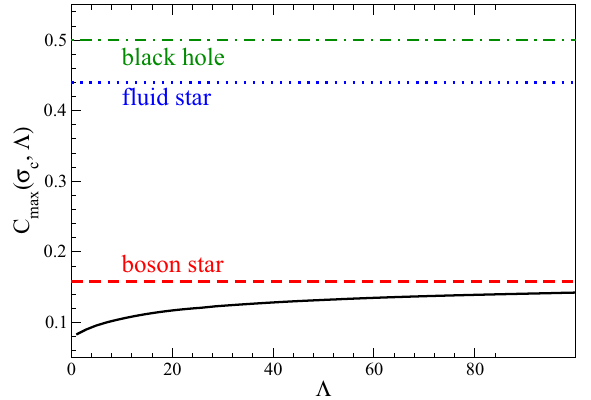
Fig. 4 The compactness of a stable boson star (black solid line) as a function of the adimensional self- (cid:6) (cid:7) interaction parameter Λ ≡ λ/ 4 π Gm 2 . The compactness is shown for the most massive stable star (the most compact BS is unstable). This compactness asymptotes for Λ → ∞ to the value indicated by the red, dashed line. Also shown for comparison is the compactness of a Schwarzschild BH (green dot-dashed line), and the maximum compactness of a non-spinning neutron star (blue dotted line). Reprinted with permission from Amaro-Seoane et al. (2010); copyright by